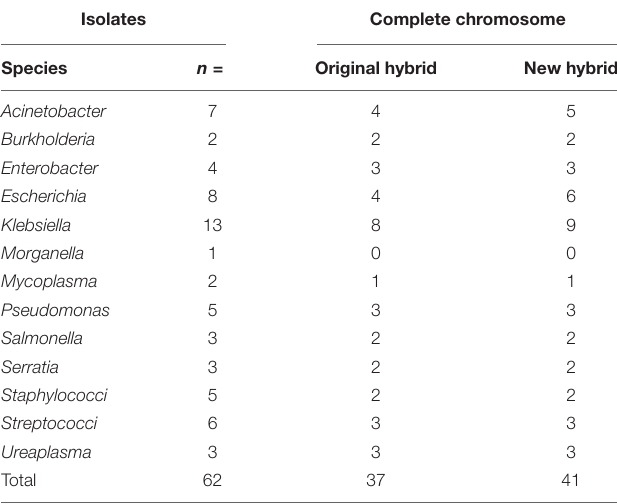
TABLE 2 | The number of isolates per genera selected for hybrid assembly using Unicycler (v0.4.7 and v0.4.9). Isolates Complete